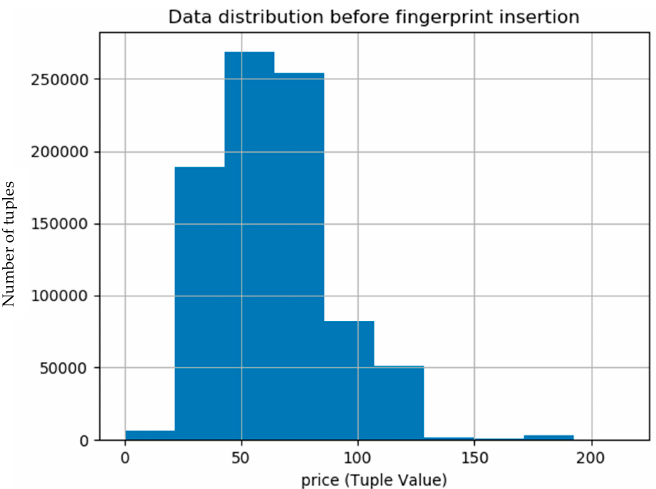
Figure 9. Histogram showing the distribution of original data.